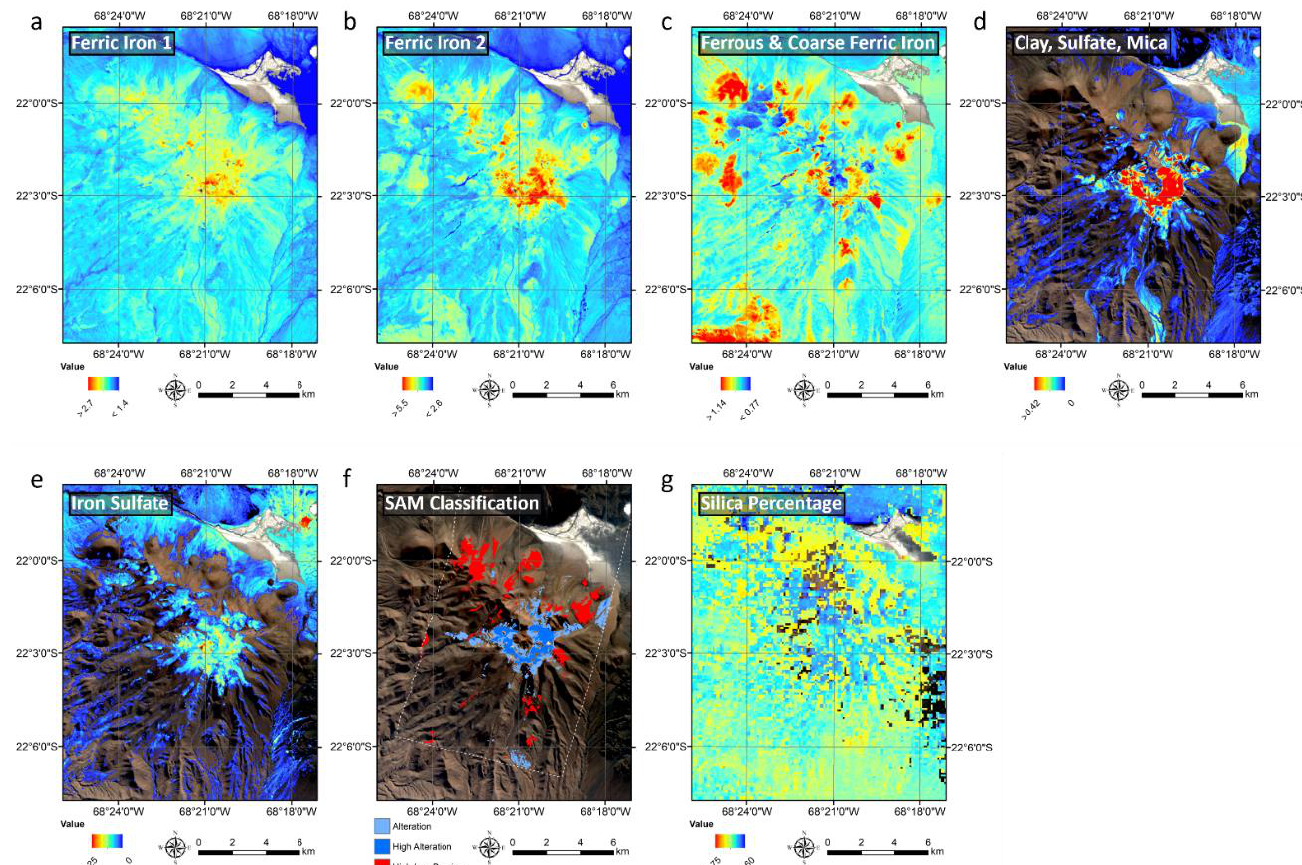
Figure 3. Maps of Cerro Carcanal and vicinity (21° 57′36″ S, 68° 25′48″W to 22°7′48″ S, 68° 17′24″ W). ( a ) Landsat 8 OLI ferric iron 1 “redness” band ratio index. ( b ) Landsat 8 OLI ferric iron 2 band ratio index. ( c ) Landsat 8 OLI ferrous/coarse-ferric iron band ratio index. ( d ) Landsat 8 OLI clay-sulfate-mica band ratio index. ( e ) Landsat 8 OLI iron-sulfate band ratio index. ( f ) EO-1 Hyperion SAM clas- sification result. “Alteration” and “High Alteration” groups are based on montmorillonite and alu- nite/kaolinite minerals, respectively. “High -Iron- Bearing” group is based on high hematite spectral signature. ( g ) Estimated silica percentage from ASTER imagery.